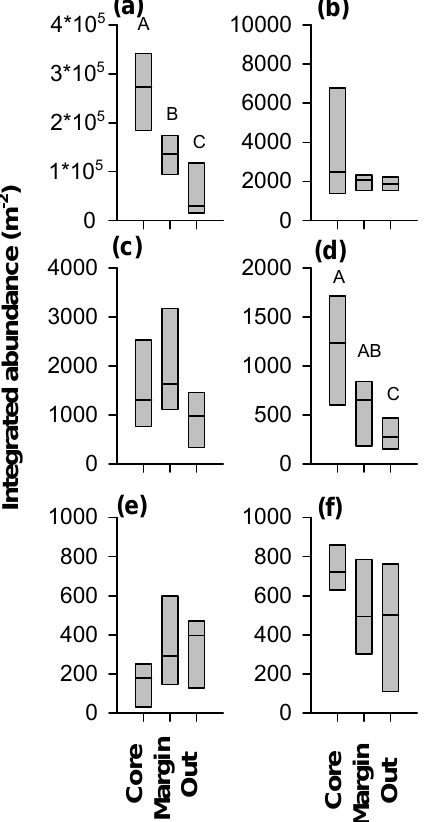
Figure 5. UVP5-derived integrated abundance (m − 2 , upper 600m) of large aggregates (>500µm) (a) , copepods (b) , collo- daria (c) , gelatinous plankton (d) , shrimp-like micronekton (eu- phausiids/decapods) (e) and phaeodaria (f) in the eddy core ( n = 4 profiles), eddy margin ( n = 4) and outside of the eddy ( n = 7). Dif- ferent letters denote significant